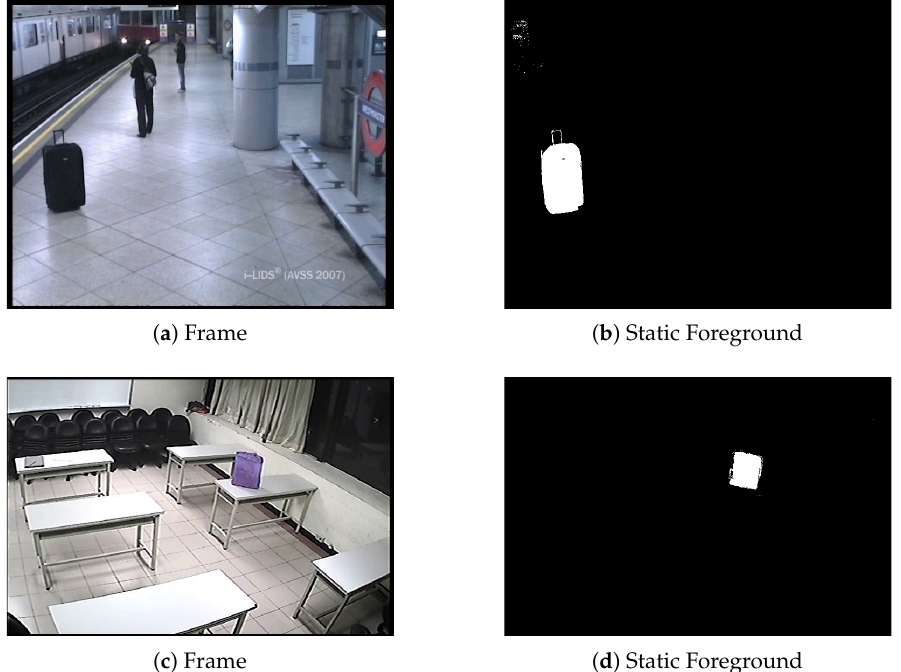
Figure 4. Static foreground detection computation using a simple persistence approach for Frame 3200 of the sequence in AVSS_AB_easy_2007 (http://www.eecs.qmul.ac.uk/~andrea/avss2007_d.html) and Frame 2000 of the sequence ABODA_video3 (http://imp.iis.sinica.edu.tw/ABODA). Subfigures ( a , c ) show both image frames, and their respective static foreground masks are depicted in subfigures ( b , d